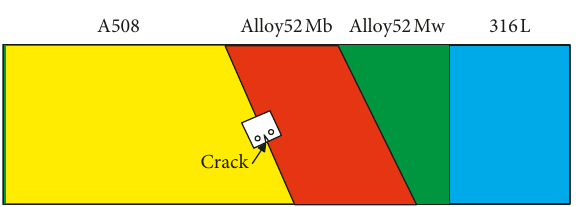
Figure 7: Schematic diagram of the crack position of the dissimilar metal welded joint at the safety